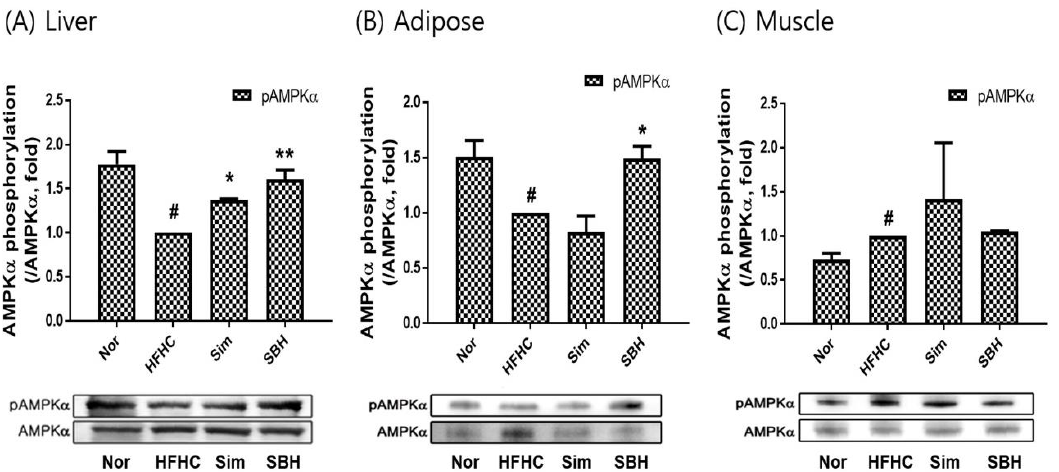
Figure 6. AMPK activity measured as phosphorylation of AMPK α in liver ( A ), adipose ( B ), and muscle ( C ) tissues. The number of experiments: Nor ( n = 3), HFHC ( n = 3), Sim ( n = 3), SBH ( n = 3). Data are expressed as the mean ± SEM. # p < 0.05 compared with Nor; * p < 0.05, ** p < 0.01 compared with HFHC. Nor, normal control group; HFHC, high-fat and high-cholesterol diet group; Sim, HFHC diet plus Sim group; SBH, HFHC diet plus SBH group.